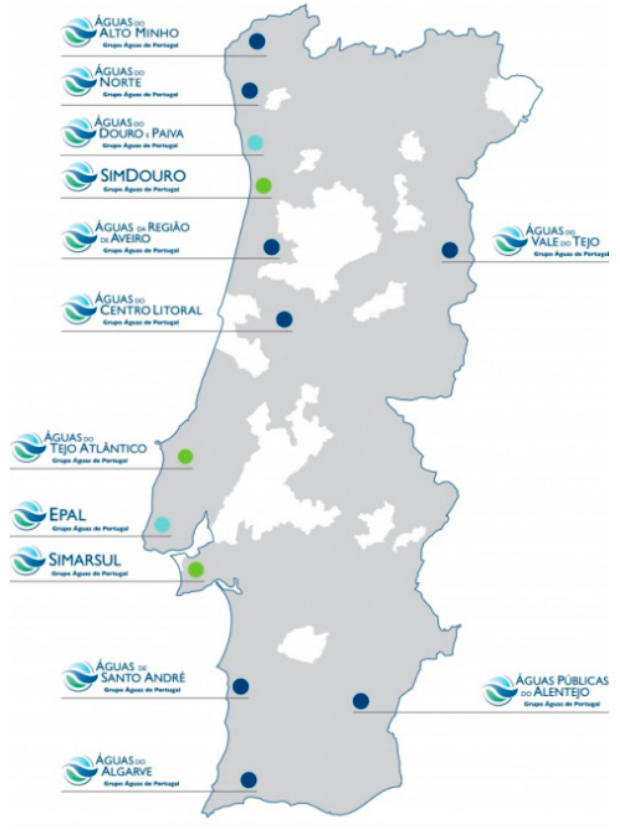
Figure 3. Companies of the Águas de Portugal (AdP) group.